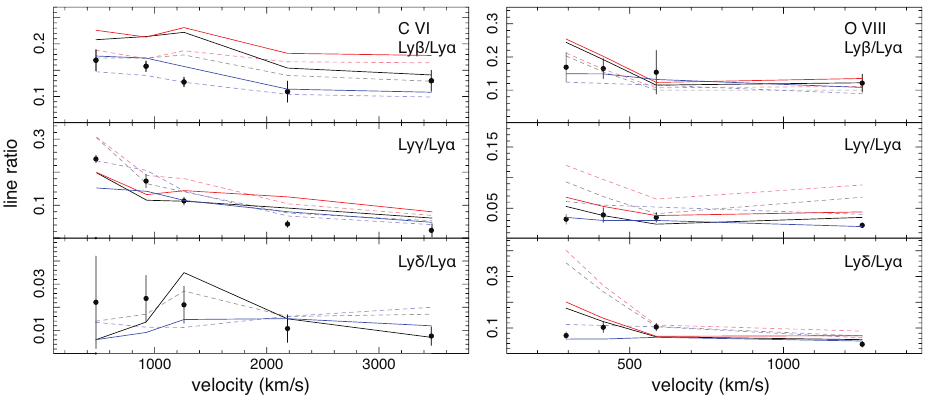
Figure 5. Comparison of experimental and theoretical line ratios for the C 6 + ( left ) and O 8 + ( right ) reactions. The experimental data from Andrianarijaona et al. [75] and Seely et al. [76] are plotted as data points, and the predictions from G16, MCLZ, and RCMD are shown in black, red, and blue curves. The dashed curves show the calculations of C 6 + and O 8 + collisions with H atoms, and the solid lines show the collisions with Kr atoms obtained using the scaling of Leung & Kirchner [77].